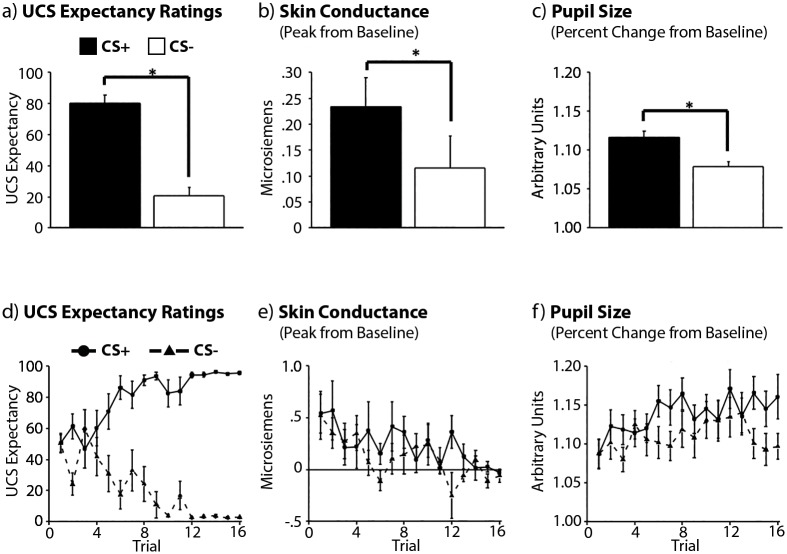
Expectancy Ratings, SCR, and Pupil Size Data.(top) Global averages, collapsed across all of the experimental trials. Participants rated the CS+ higher than the CS- in online dial-based expectancy ratings (a) and also showed larger magnitude SCRs (b) and pupil size (c) to CS+ than CS- trials. (bottom) Trial-by-trial illustration of the expectancy, SCR, and pupil dilation data. Online expectancy ratings (d) were increasingly sensitive to differentiation of the CS+ from the CS- across trials. The magnitude of SCRs (e) declined across trials, whereas pupil size (f) increased; neither SCRs nor pupil size measures showed changes in sensitivity to learning as the experiment progressed. Error bars show SEM.